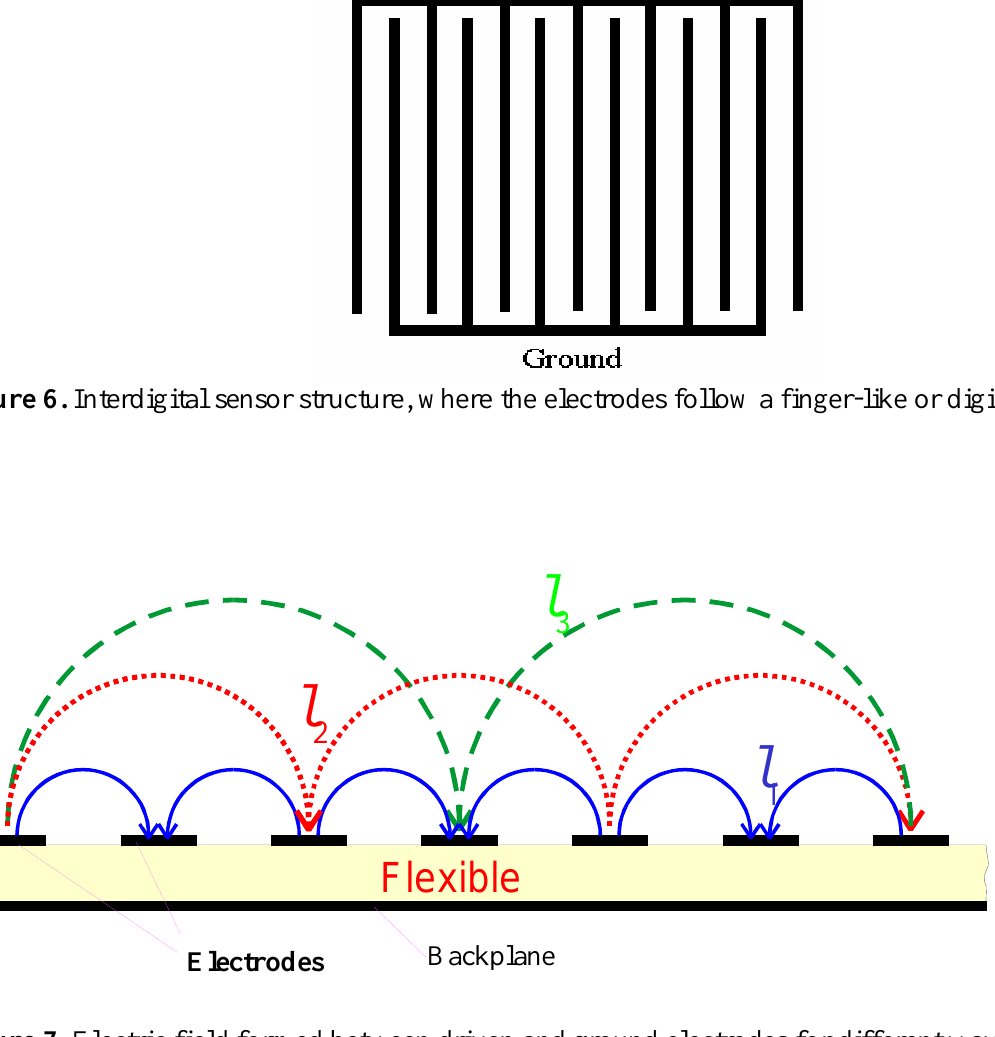
Figure 7. Electric field formed between driven and ground electrodes for different wavelengths. Four interdigital sensors of different wavelengths and lengths were designed on Protel DXP 2004. The sensor parameters are shown in table 3 below. The sensor schematic is shown in figure 8. Table 3. Interdigital sensor